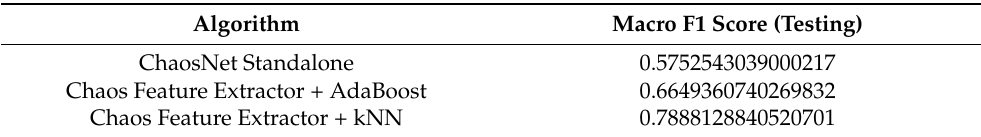
Table 2. Comparison metrics for the algorithms used in the article based on their macro F1 score when they were subjected to